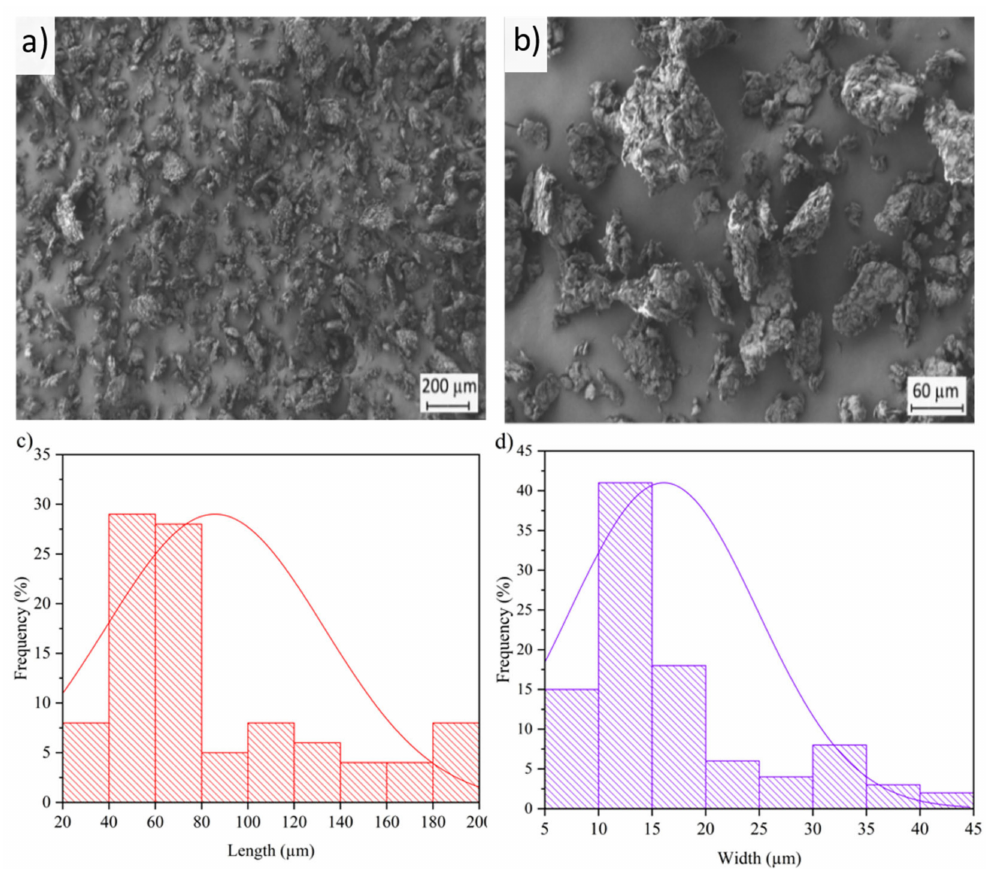
Figure 1. ( a ) Field emission scanning electron microscopy (FESEM) images of micronized pistachio shell flour (PSF) taken with a magnification of 50 × and a scale marker of 200 µ m; ( b ) FESEM image of PSF taken with a magnification of 200 × and a scale marker of 60 µ m; ( c) histogram of the PSF particle length; ( d ) histogram of the PSF particle width.